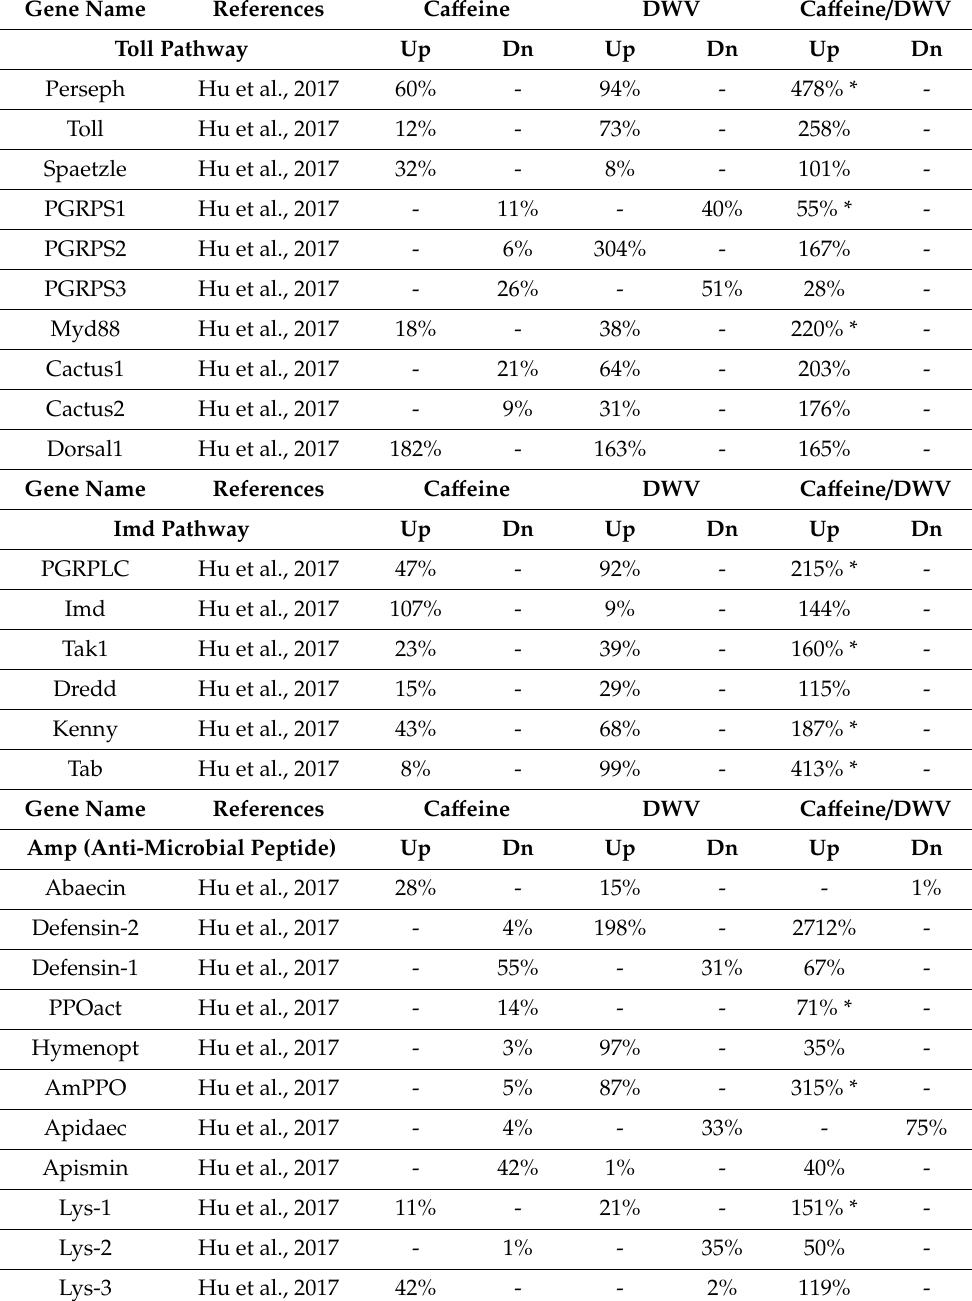
Table 2. Relative expression of immune-related genes in honeybees of mixed group. The results were done by real-time PCR. The values in the table represent how much percent the relative gene expression level up- / down-regulated than control group in each treatment group. Statistical analysis was done by one-way ANOVA followed by Tukey’s post hoc test. “*” indicate p -values < 0.05. (Ca ff eine / DWV compared to